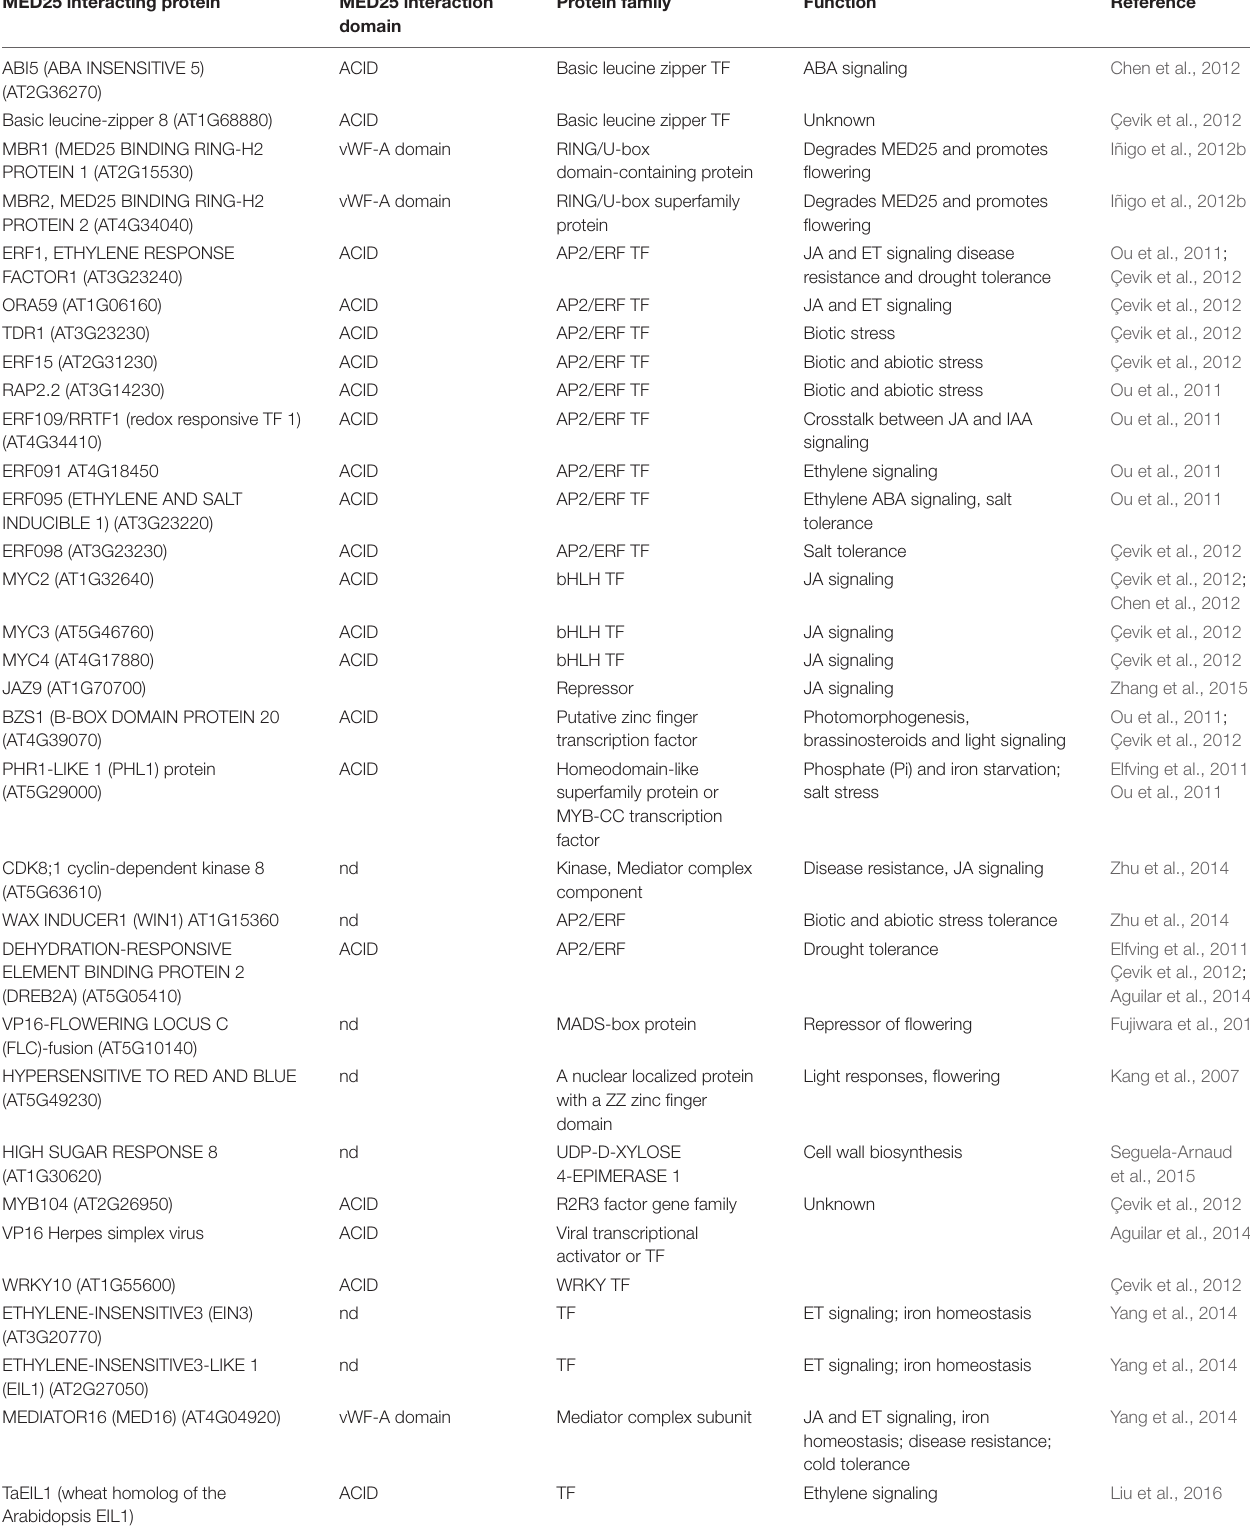
TABLE 1 | MED25 interacting proteins. MED25 interacting protein MED25 interaction